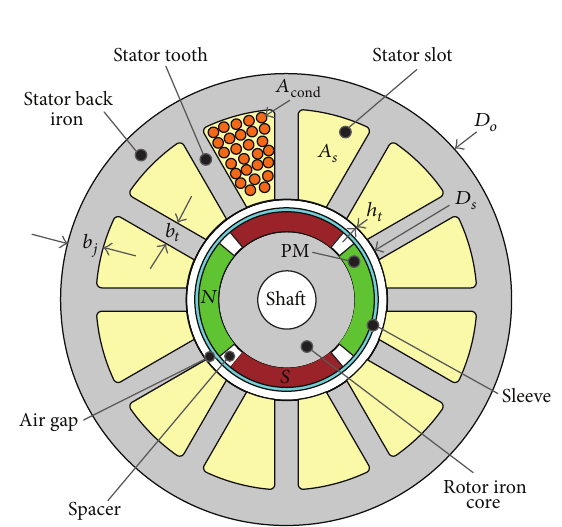
Figure 2: Configuration and geometric parameters of the PM-